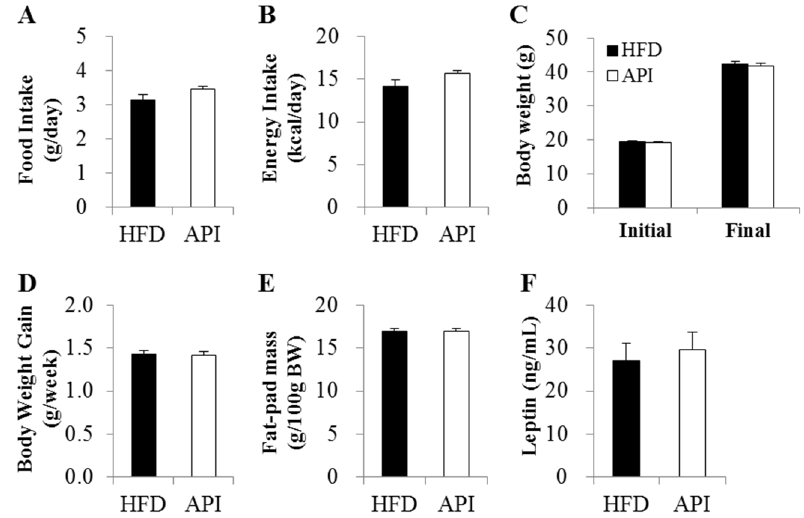
Figure 1. Effects of apigenin on ( A ) food intake; ( B ) energy intake; ( C , D ) body weight; ( E ) fat ‐ pad mass and ( F ) plasma leptin level in C57BL/6J mice fed a high ‐ fat diet. Data are shown as the means ± S.E. HFD: high ‐ fat diet (20% fat, 1% cholesterol); API: HFD + 0.005% apigenin.